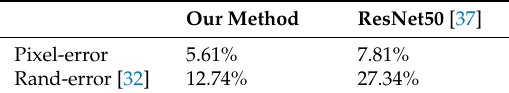
Table 2. Comparison of neuron